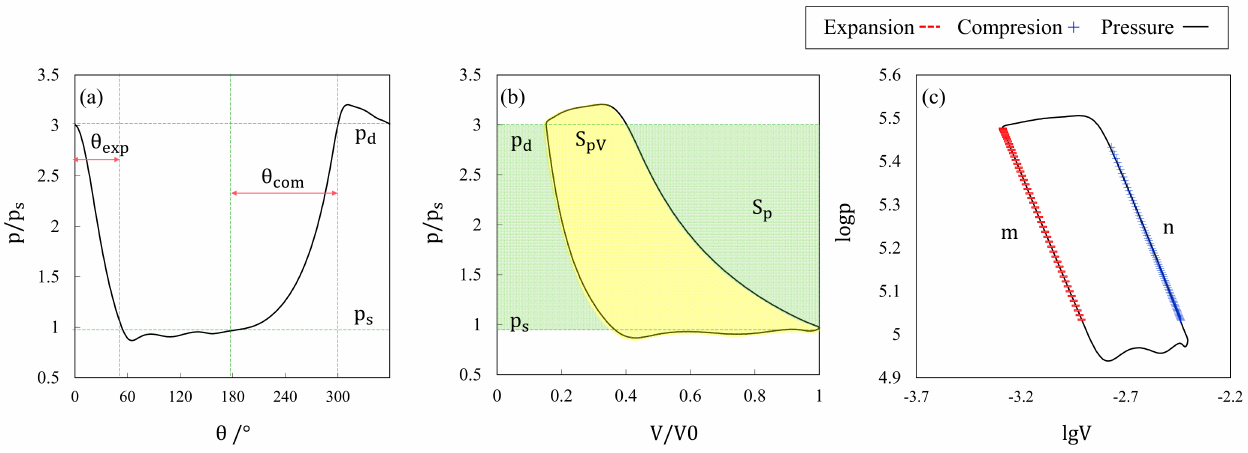
Figure 4. Characteristic parameters of the p − V diagram ( a ), p − θ diagram ( b ) and lgp − V diagram ( c